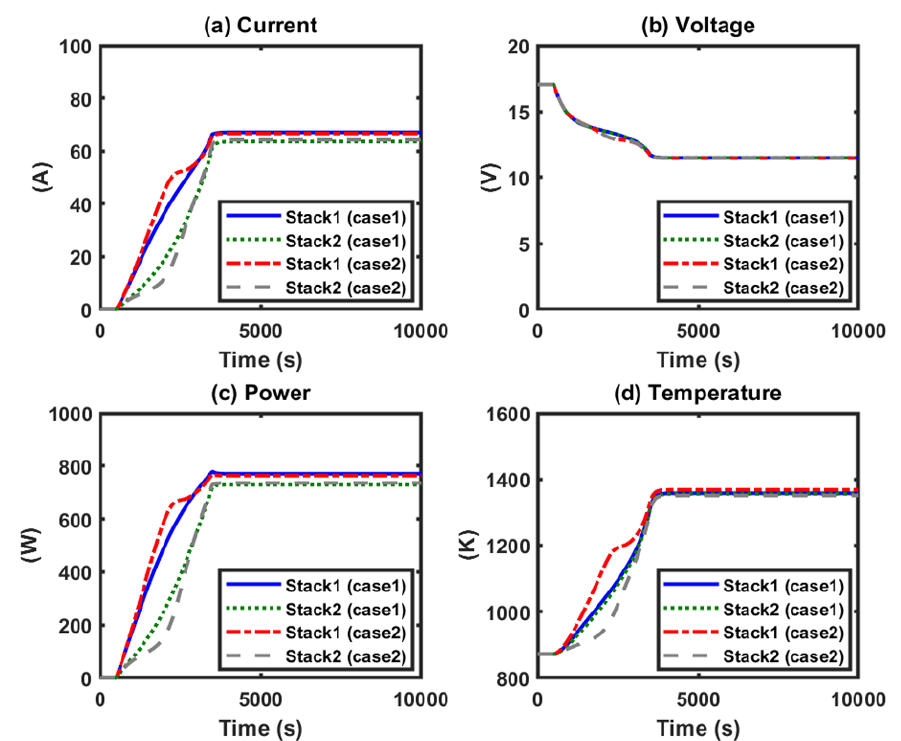
Figure 10. Transient response of the parallel-connected stacks when the two employed stacks have di ff erent ohmic properties and a lower heat capacity. Case 1 includes the heat exchange between stacks, whereas case 2 excludes it. ( a ) Stack output current, ( b ) stack voltage, ( c ) stack output power, and ( d ) stack temperature. The steady-state performance of the two cases and stacks are almost the same.